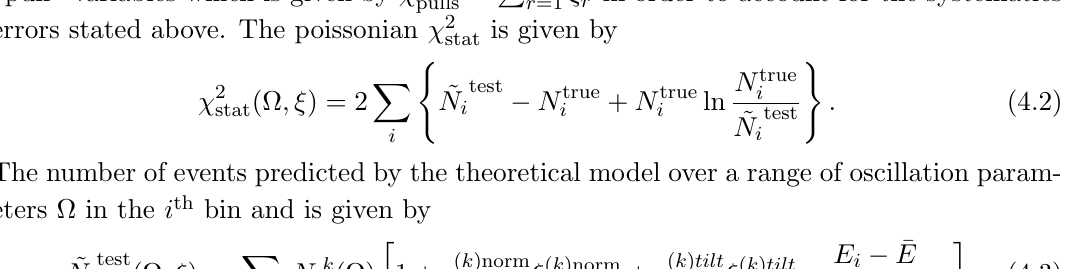
= P r =4 (cid:24) 2 in order to account for the systematics r r =1 pulls is given stat